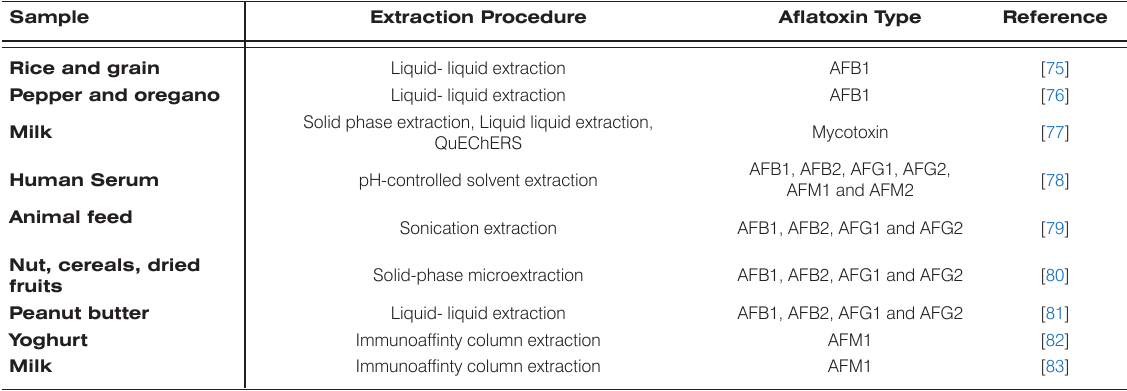
Table 3. Extraction procedures of some samples for determination of aflotoxin